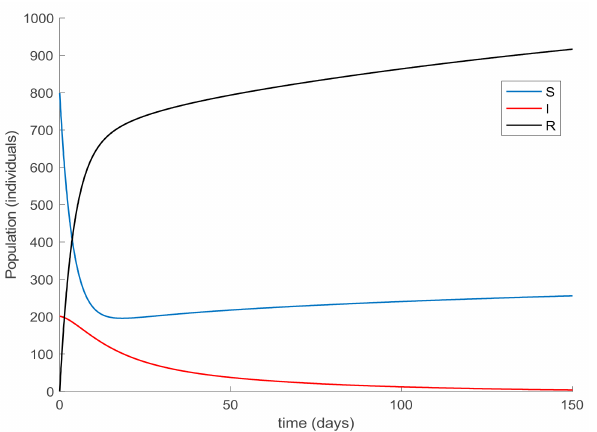
Figure 5. Evolution of all of the subpopulations when a constant vaccination of 20% of the susceptible subpopulation is added to the control of the contagion rate. The value of β is given by Figure 3.